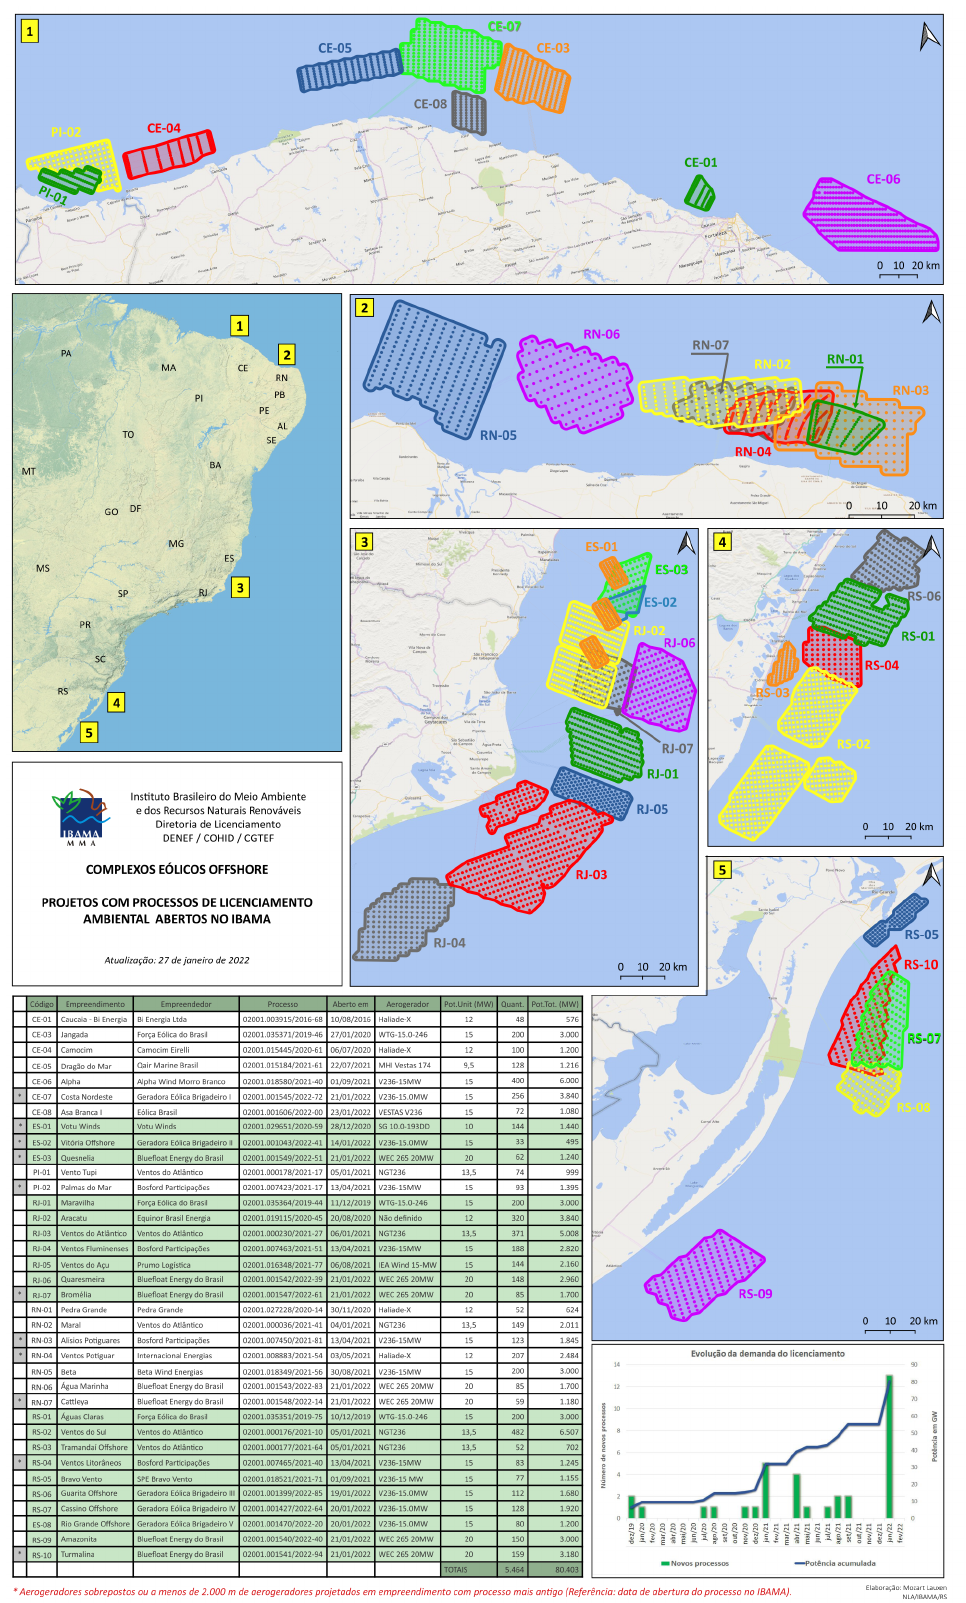
Figure A1. Brazil offshore wind farms under environmental licensing at IBAMA [50]. The insert table lists the 36 offshore projects, their location, owner, type and number of turbines, and farm installation capacity in